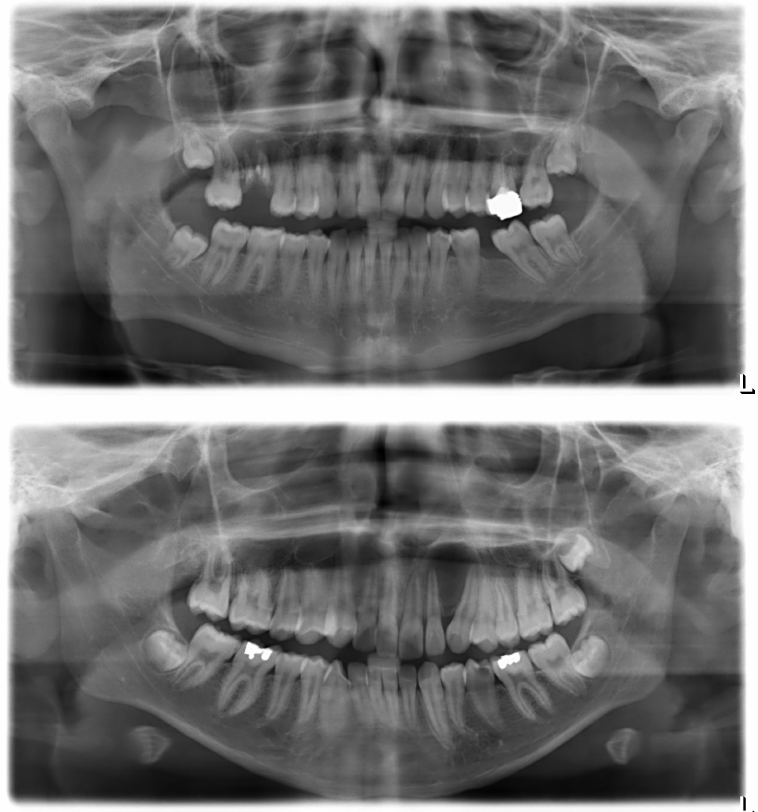
Figure A1. Sample panoramic radiographs for odontogenic and non-odontogenic cysts. Top , odonto- genic (radicular) cyst at the upper right first molar. The radiolucency appears centered around the roots of the affected tooth, which clearly shows multiple signs of pathology. Bottom , non-odontogenic (globulomaxillary) cyst between the upper left lateral incisor and canine. There is no sign of pri- mary pathology of either the incisor or the canine; their displacement is an assumed consequence of cystic growth.